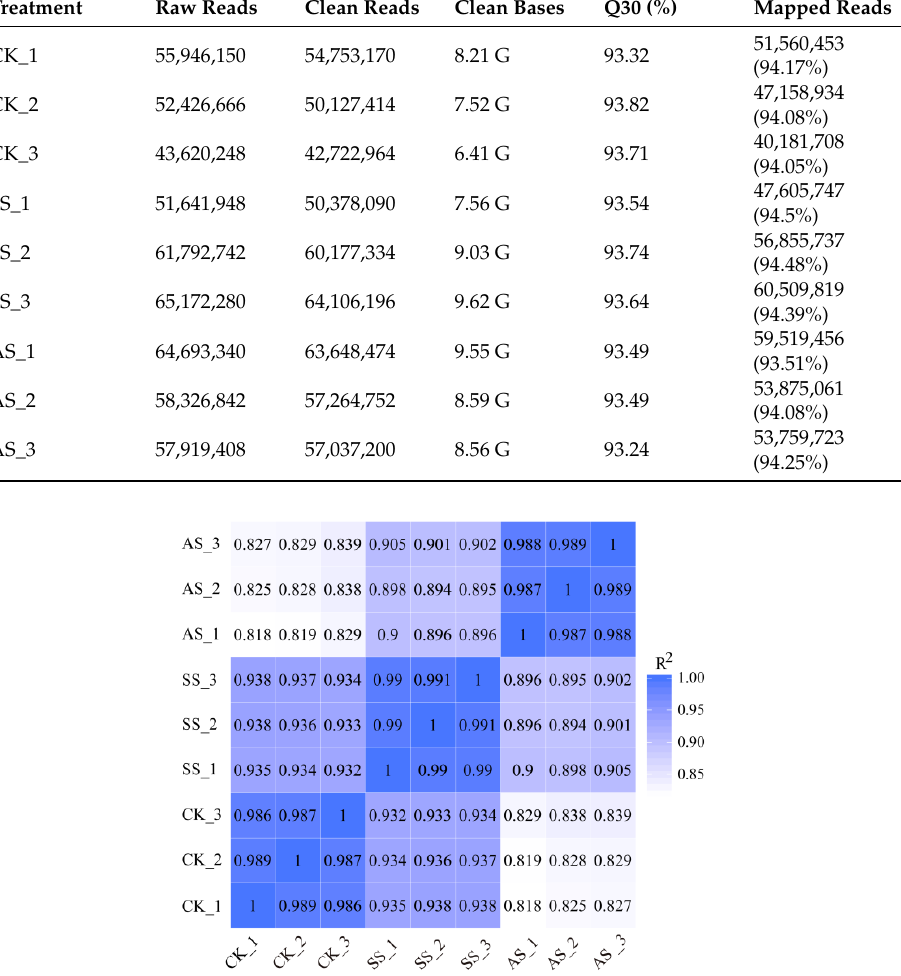
Figure 1. Heatmap of Pearson correlations of the expression levels among samples. CK: control samples, SS: 100 mM NaCl-treated samples, AS: 100 mM NaHCO 3 -treated samples. The numbers